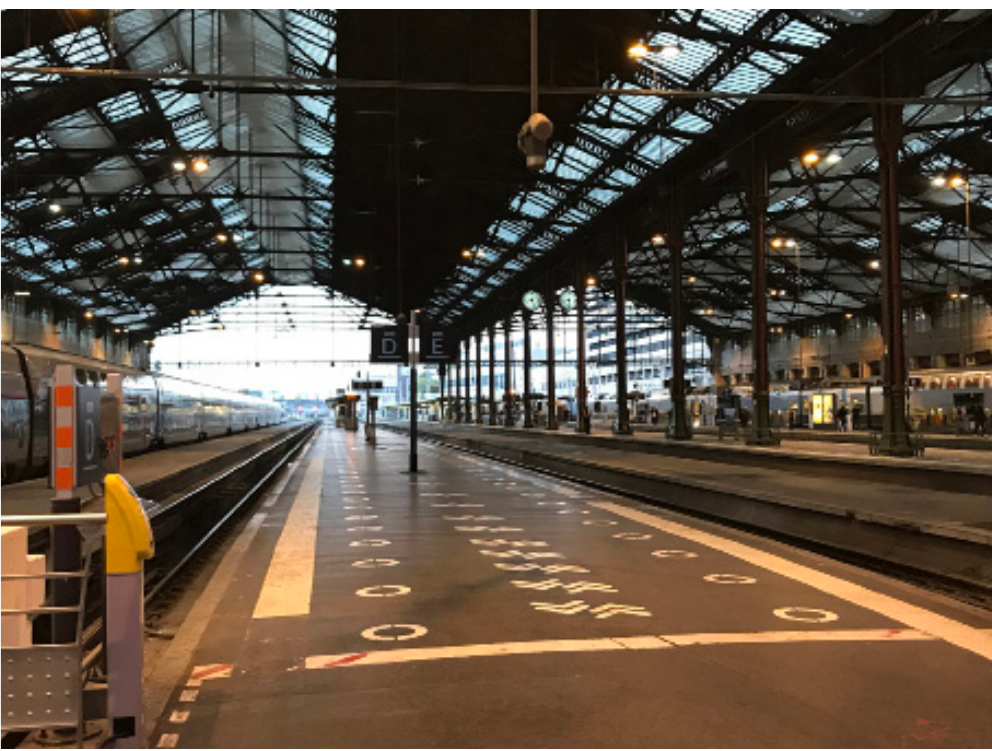
Fig. 2 Gare de Lyon, Paris (photos from the